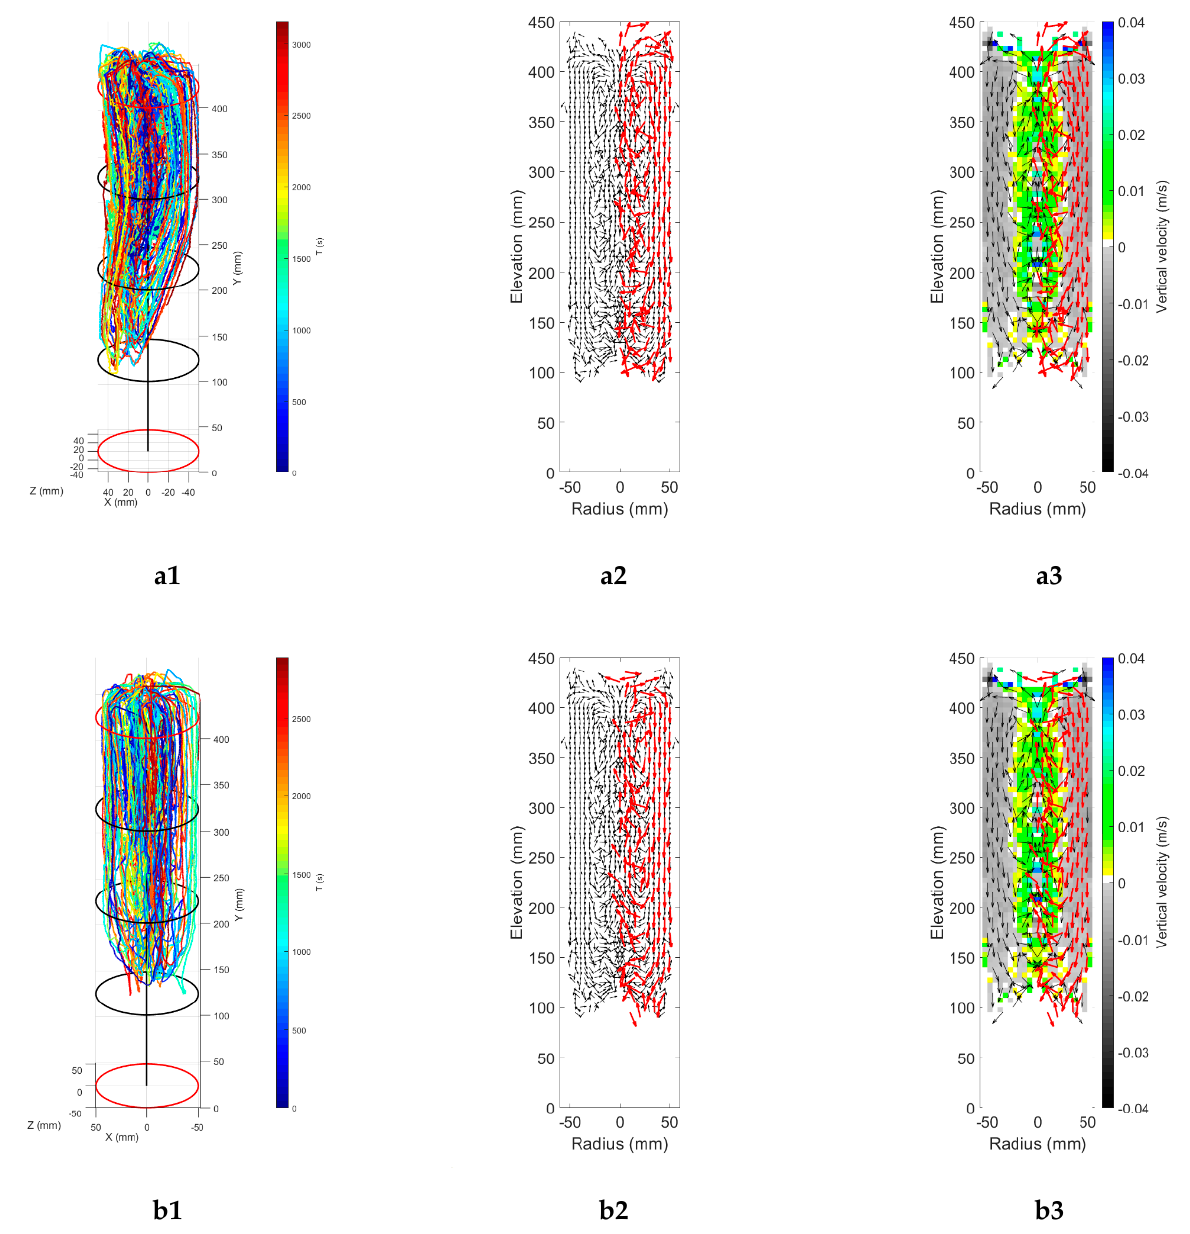
Figure 7. The results of 2 runs ( a , b ) of the − 150 + 106 µm hematite particle for an airflow rate of 1.25 u mf (Lagrangian trajectory (1) and Eulerian flow maps (2 and 3)).